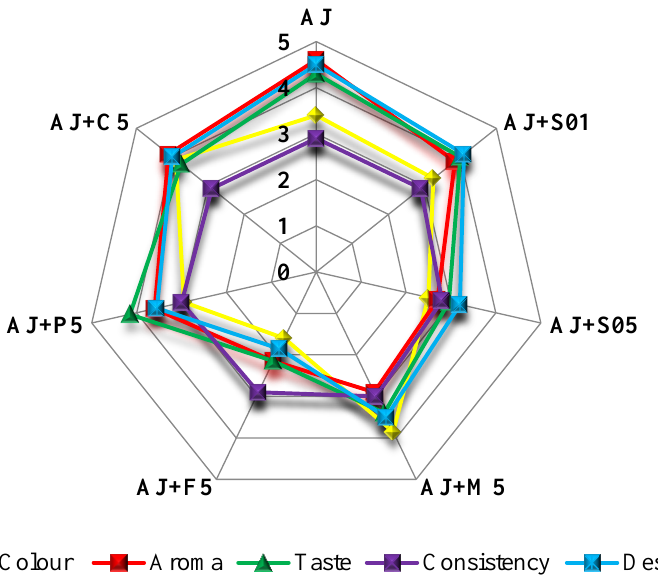
Figure 2. Consumer evaluation of enriched apple juices (5° hedonic scale). Sensory evaluation was carried out in analysed juices immediately after processing. The presented values are the average of all evaluations. AJ—apple juice; AJ+S01—apple juice + 0.1% saffron flower juice; AJ+S05—apple juice + 0.5% saffron flower juice; AJ+M5—apple juice + 5% myrtle berry extract; AJ+F5—apple juice + 5% feijoa flowers; AJ+P—apple juice + 5% persimmon pur é e; AJ+C—apple juice + 5% strawberry tree fruits.